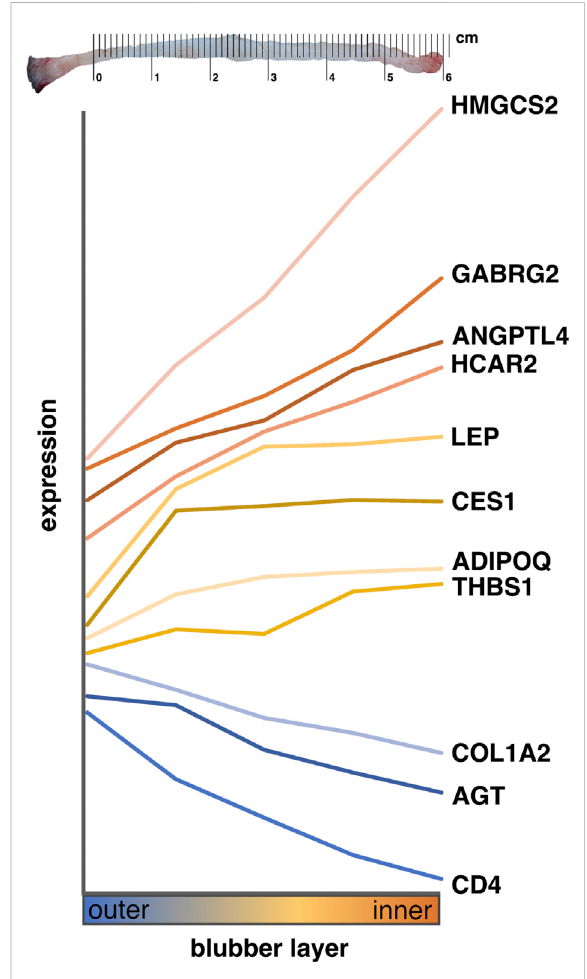
FIGURE 7 Summary of gene expression across blubber depth in elephant seals. Lines show mean normalized expression levels (delta C T ) of genes shown in Figure 5 across fi ve blubber layers. Genes are ordered by expression pattern across blubber depth, not absoluteexpression level. Genesshown inorange were most highly expressed in innermost blubber, those shown in yellow had highest expression in middle and inner blubber layers, and those shown in blue wereexpressedmosthighly in outermost blubber. Metric ruler was created using Vector Ruler Generator (MIT